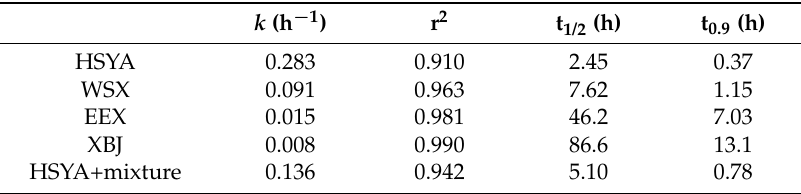
Table 4. Kinetic parameters of HSYA degradation under specified conditions.